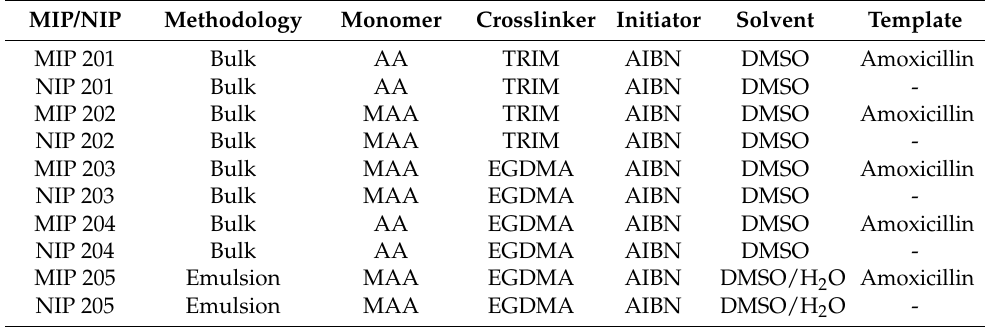
Table 1. MIP/NIP